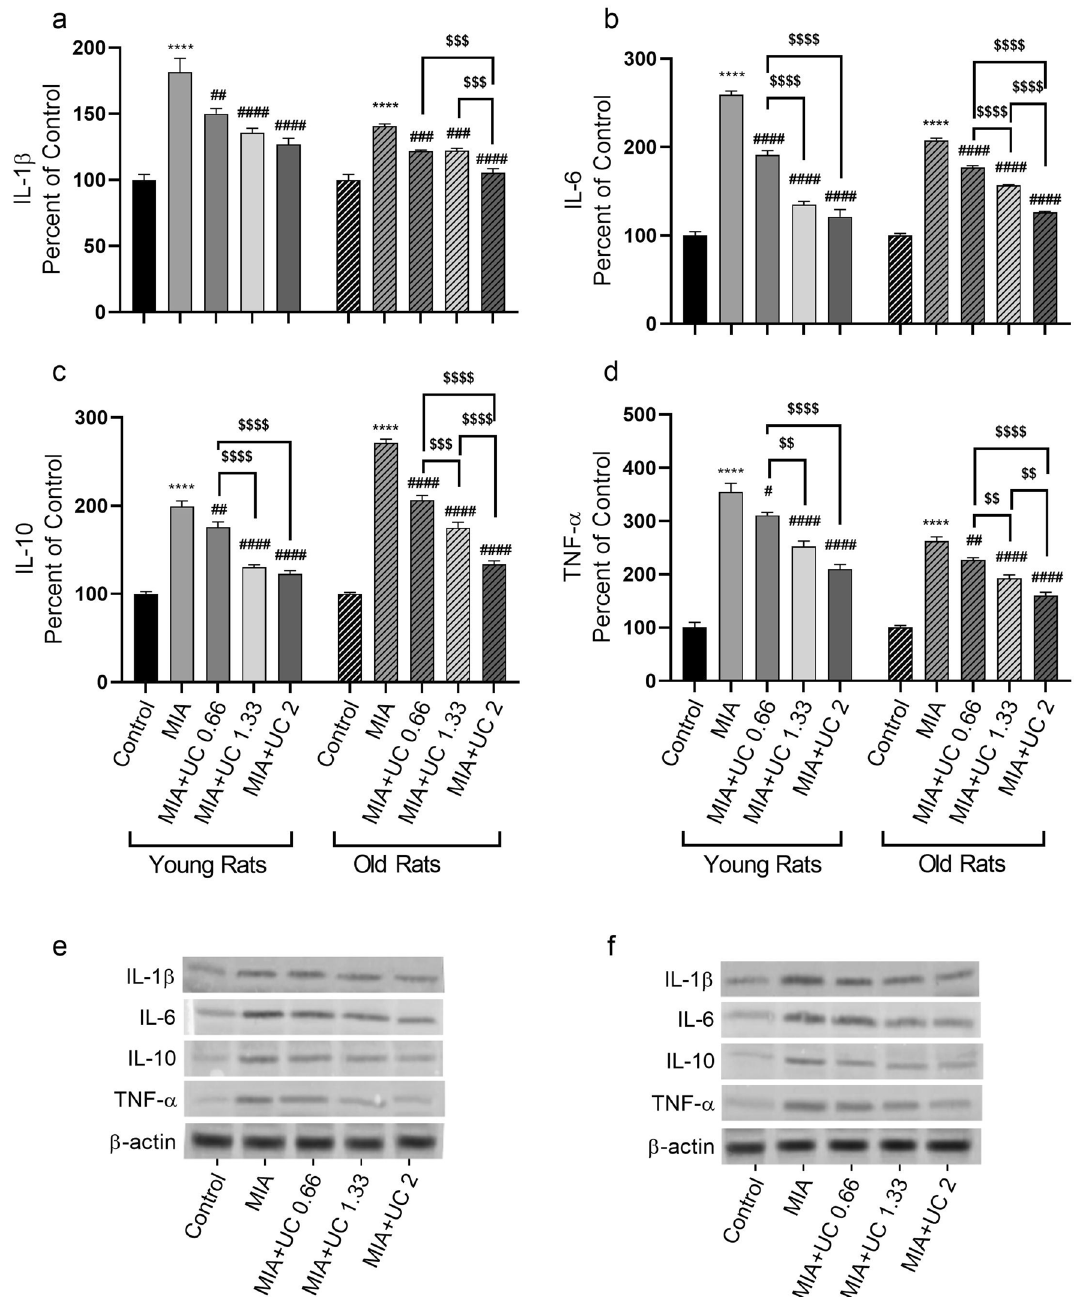
Figure 6. Effects of undenatured collagen (UC) supplementation at different doses on knee joint protein expression of IL-1β ( a ), IL-6 ( b ), IL-10 ( c ), and TNF-α ( d ), levels in monosodium iodoacetate (MIA) induced osteoarthritis in young and old rats. The densitometric analysis of the relative intensity according to the control group of the western blot bands was performed with β-actin normalization to ensure equal protein loading. Blots were repeated at least three times (n = 3), and representative blots were shown ( e for young rats and f for old rats). The bars point out the mean ± standard error of the mean (SEM). ANOVA and Tukey’s post hoc test were used to compare the results among different treatment groups. Statistical analysis was performed separately within each age group. Statistical significance between groups is shown by: **** p < 0.0001 (MIA vs. Control), and # p < 0.05; ## p < 0.01; ### p < 0.001; #### p < 0.0001 (MIA vs. UC groups), and $$ p < 0.01; $$$ p < 0.001; $$$$ p < 0.0001 (pairwise comparisons between UC